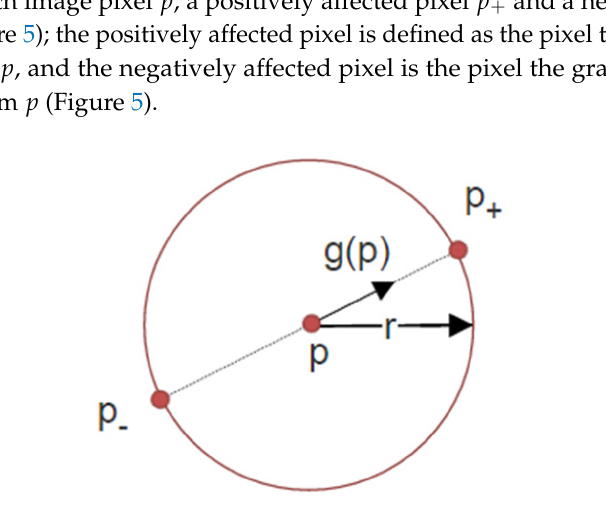
Figure 5. Positive and negatively affected pixels: the positively affected pixel ( p + ) is the pixels the gradient is pointing to at r distance away from p , while the negatively affected pixel ( p − ) is the pixel the gradient is pointing away from at distance r